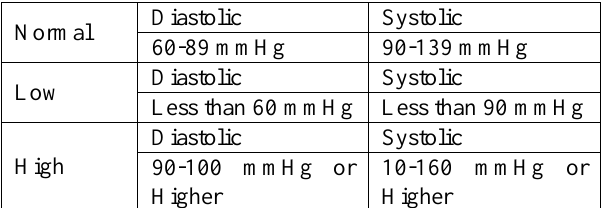
Table 4. Investigation ranges of blood pressure